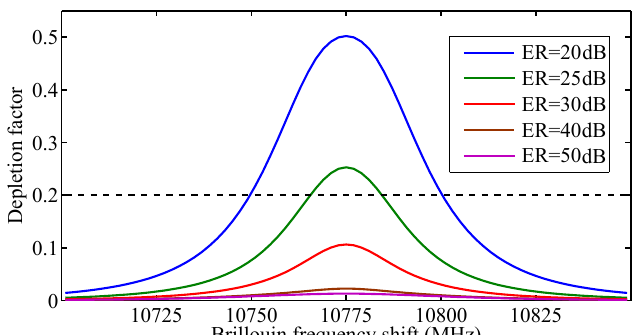
Figure 7. Depletion spectrum of the pulse for different ER pulses of 20 dBm counter-propagating to a − 3 dBm probe wave power per sideband in a 25-km length single-mode